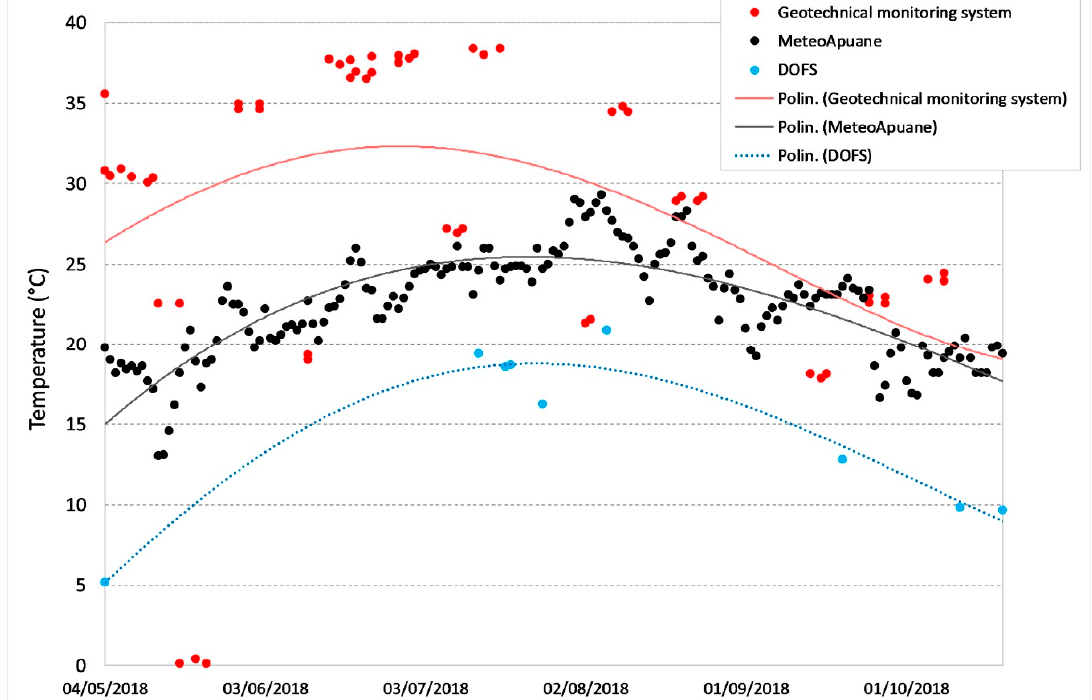
Figure 30. Comparison between the temperature values measured by DOFS, FS1 geotechnical sensor and “Carrara Fossola” weather station. The data were interpreted according to a fifth order polynomial.